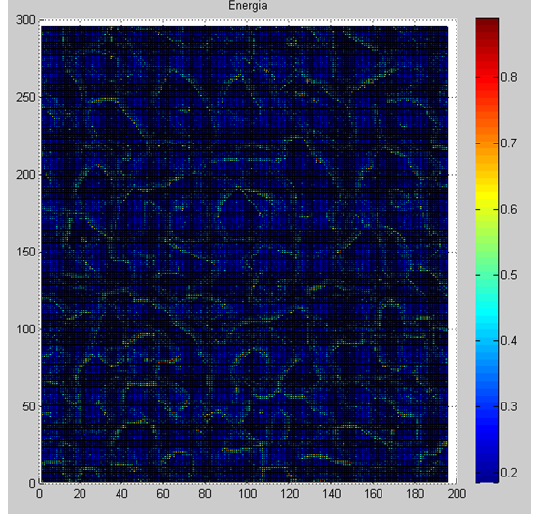
Figure 10: Energy indicator